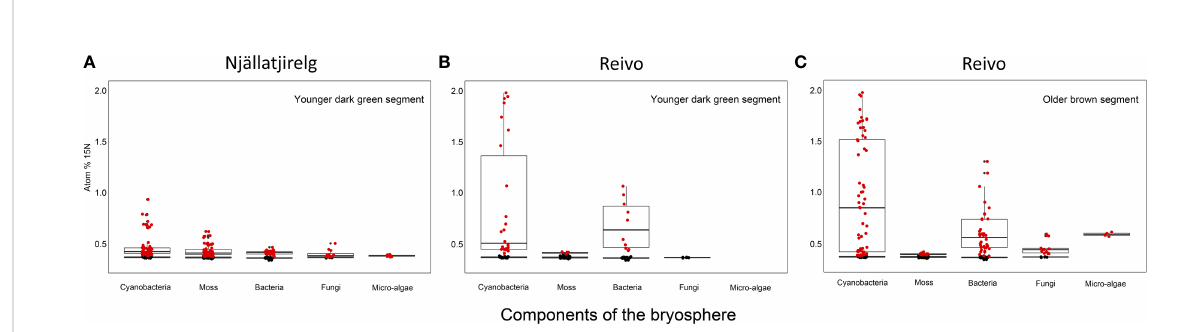
FIGURE 1 15 N accumulation (atom% 15 N) of metabolically active cell components of the bryosphere of two northern Sweden boreal forest after 15 N 2 incubation. (A) Upper younger dark green segment of Pleurozium schreberi shoot from Njällatjirelg, an open canopy forest with high moss N 2 fi xation, and (B) from Reivo, a variably dense canopy forest with moderately high N fi xation in the moss layer, and (C) lower older brown 2 segment of P. schreberi shoot from Reivo. Data from unlabeled replicates from each site used to generate 15 N natural abundance values of each component - shown as black dots. Only data from the active (i.e. 15 N enriched, red dots) cells is presented, > 95% con fi dence intervals of unlabeled controls and error (2 s , Poisson) smaller than the difference between the atom % of the labeled sample and the mean atom % of unlabeled control samples. Box plots summarize the quartiles of the target components of the bryosphere where boxes and whiskers encompass 25 – 75% and 5 – 95% quantiles of the data, respectively, with the median indicated by a dark horizontal line. Samples from the brown segments of P. schreberi from Njällatjirelg were removed from data analysis after NanoSIMS measurements since we could not detect 15 N enrichment despite the presence of cyanobacteria. Branch location along the moss shoot selected for NanoSIMS analysis and raw images